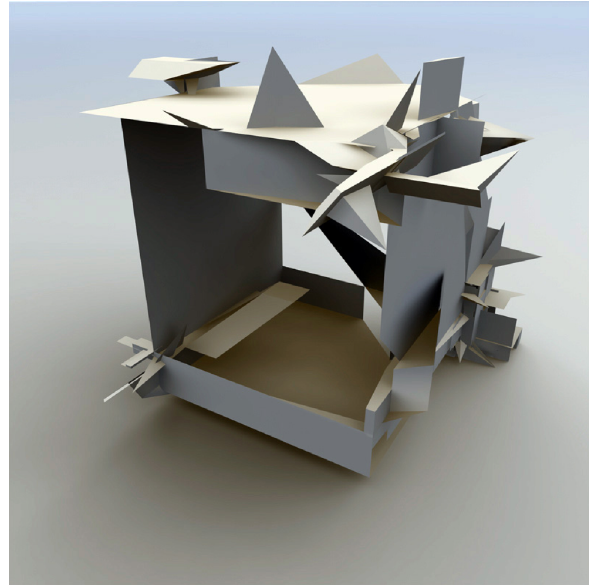
Figure 2 | On the Origin of Species: The Preservation of Favoured Traces, Fry, 2009. Figure 4 | Spam Architecture, Dragulescu, 2005.